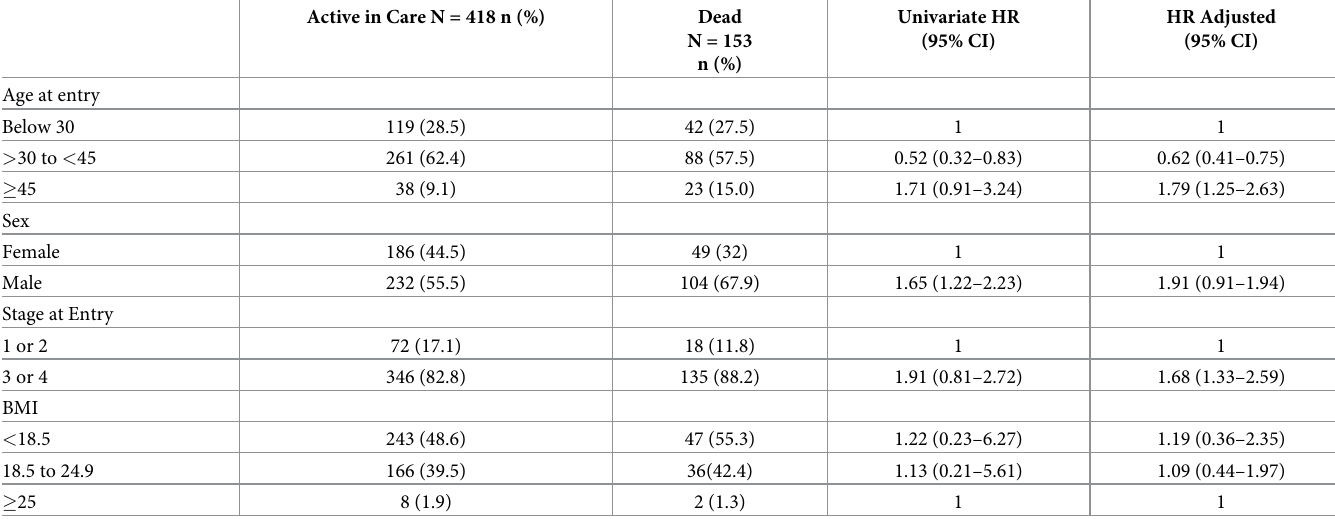
Table 2. Univariate and multivariate hazard ratios (HR) for